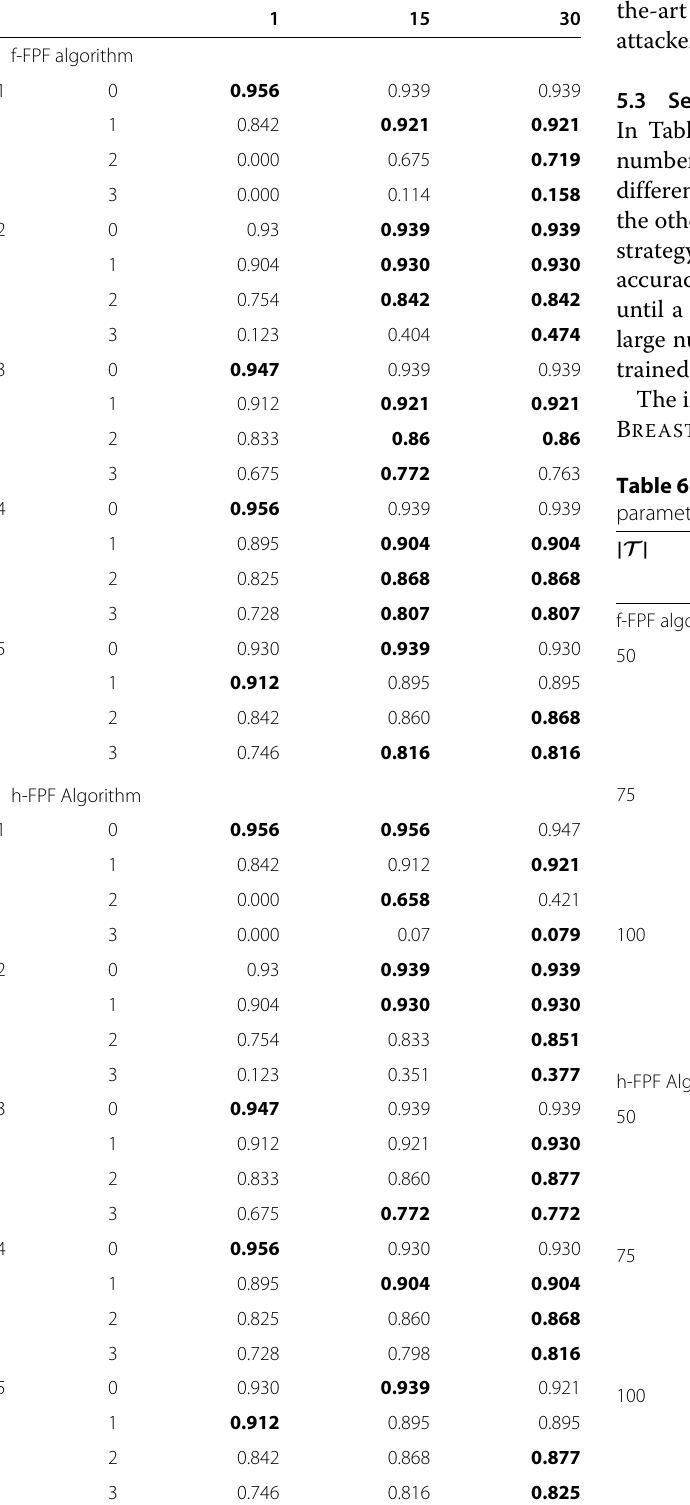
Table 5 Sensitivity analysis with respect to the number of rounds r on the B REAST _C ANCER dataset